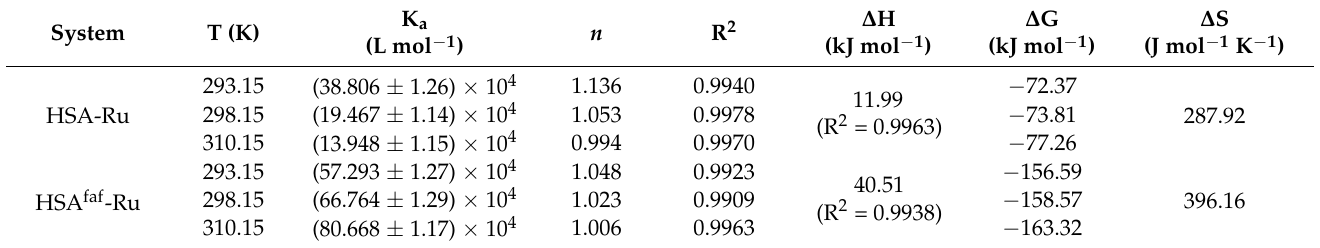
Table 6. Binding and thermodynamic parameters of HSA-Ru and HSA faf -Ru systems at different